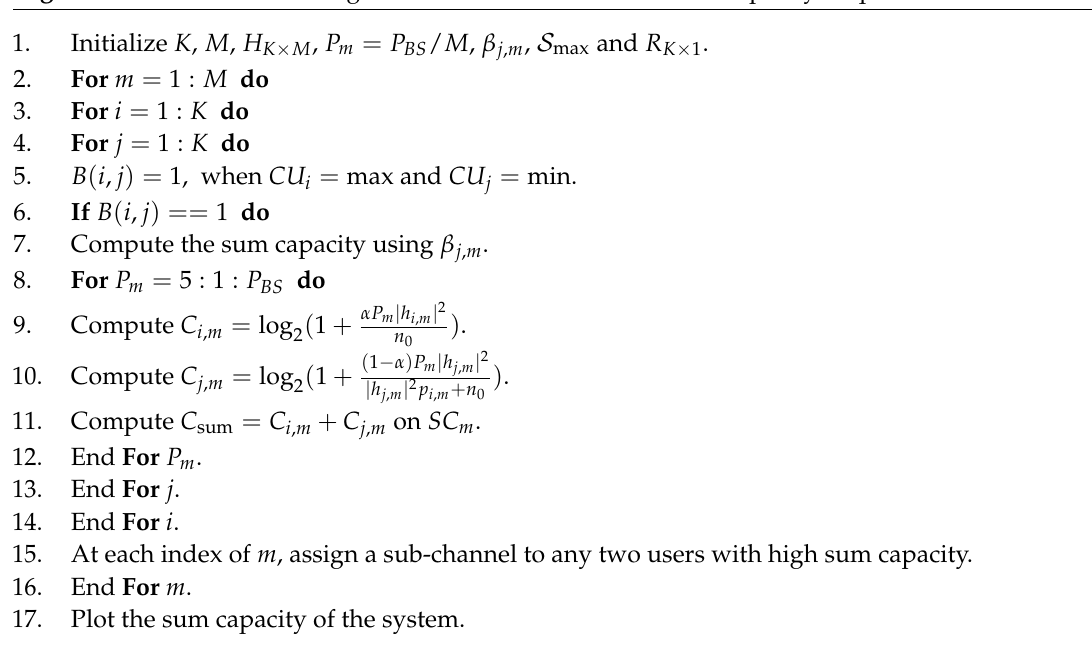
Algorithm 2 Sub-channel Assignment Based on User Minimum Capacity